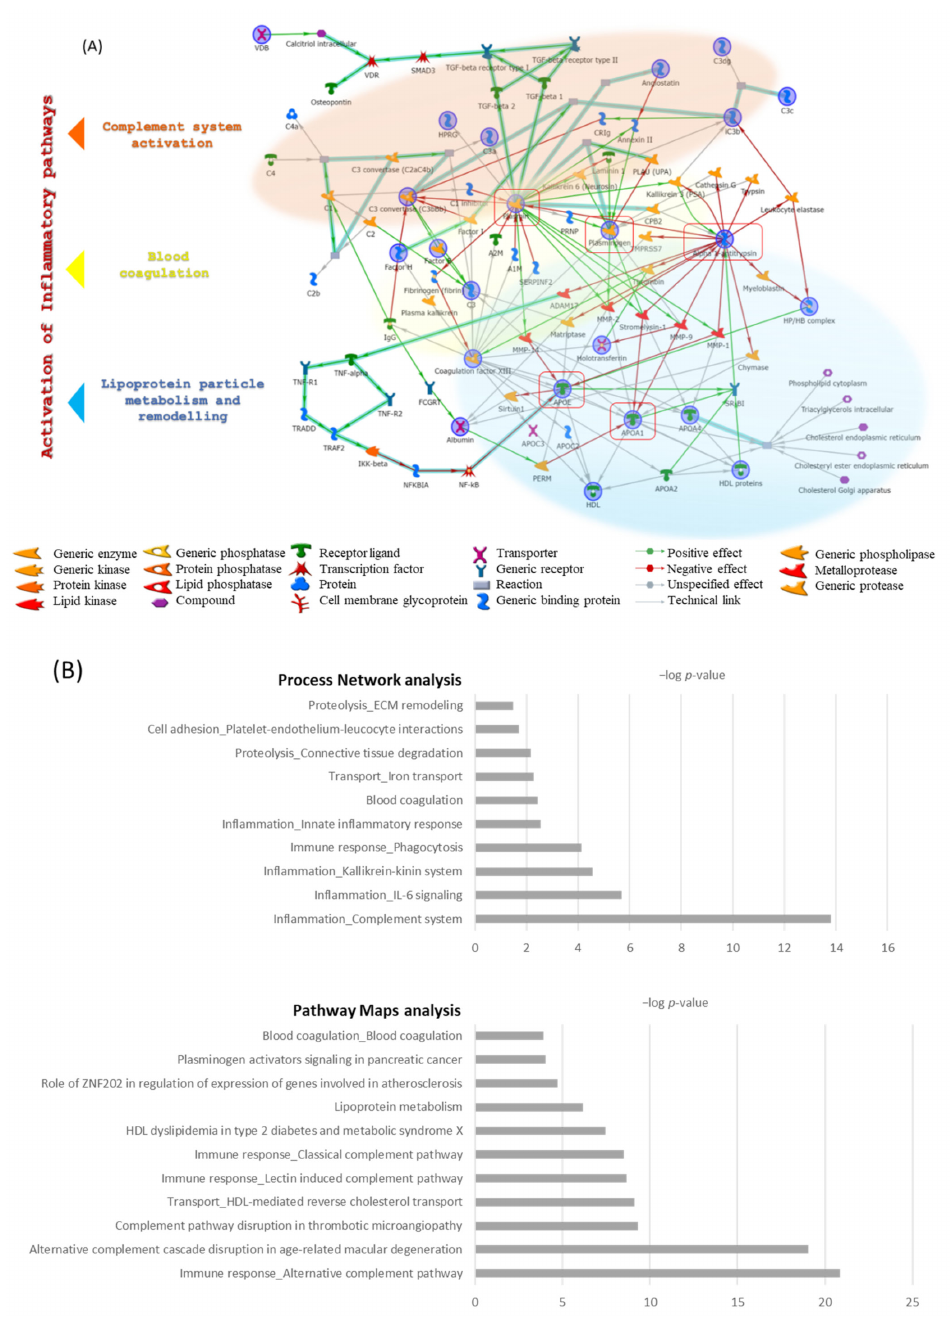
Figure 6. ( A ) Protein network built by MetaCore software, which uploaded the 34 differential abundant proteins (DAPs). Alpha 1-antitrypsin, apolipoprotein E (APOE), plasminogen, plasmin, and apolipoprotein AI (APOA1) are central functional hubs, circled in red. Three principal molecular paths are evidenced by colored clouds, respectively, in yellow corresponding to blood coagulation, orange as a complement system, and blue as lipoprotein particle remodeling. A legend of MetaCore symbols is reported under the protein network. ( B ) Histograms report the process network and pathway maps analyses